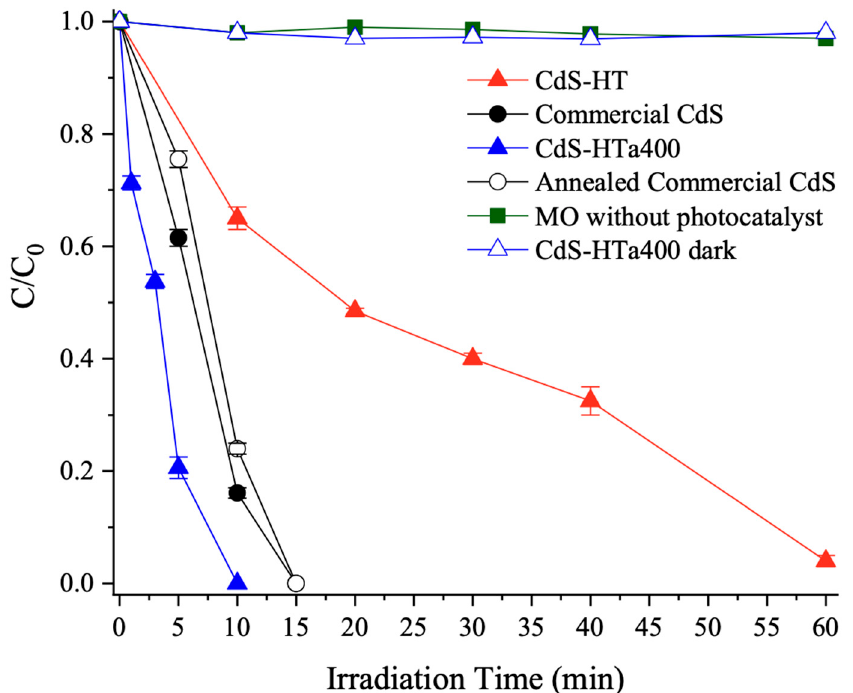
Figure 7. C/Co ratio vs. time profiles obtained upon irradiation ( λ > 400 nm) of CdS-HT (red full triangles), CdS-HTa400 (blue full triangles), commercial CdS (black full circles) and commercial CdS annealed at 400 °C (black empty circles) suspended in deaerated aqueous solution containing EtOH 10% v / v and MO (C 0 = 10 ppm). Control experiments with MO solution irradiated without photocatalysts (green full squares) and MO solution kept in dark in the presence of CdS-HTa400 (blue empty triangles) are also present .